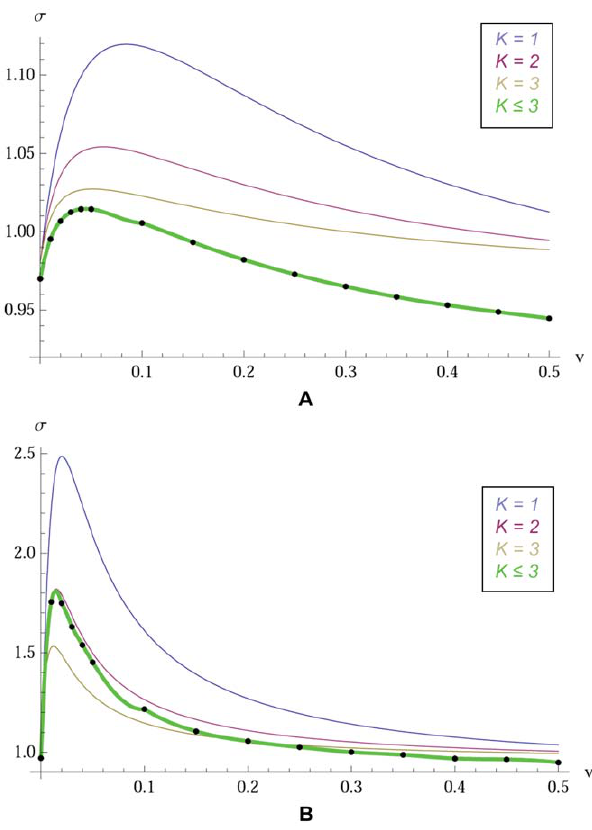
Figure 3. Simulated results for model with variable number of set memberships. An individual can be in 1, 2, or 3 sets; when he mutates set membership, the number of sets he joins is drawn with uniform probability. Parameter values are N ~ 100 , M ~ 10 ; u is the strategy mutation rate and v is the set mutation rate. We run the simulation using the method of eq. (3) for 10 7 generations. Dots indicate simulated results, which are interpolated with a smooth curve. This variable set membership model has not yet been solved analytically. (A) The interpolated curve for small strategy mutation ( u ~ 0 : 002) compared to the analytical result for K ~ 1,2 or 3 . (B) The interpolated curve for high strategy mutation rate ( u ~ 0 : 2) compared to the analytical result for K ~ 1,2 or 3